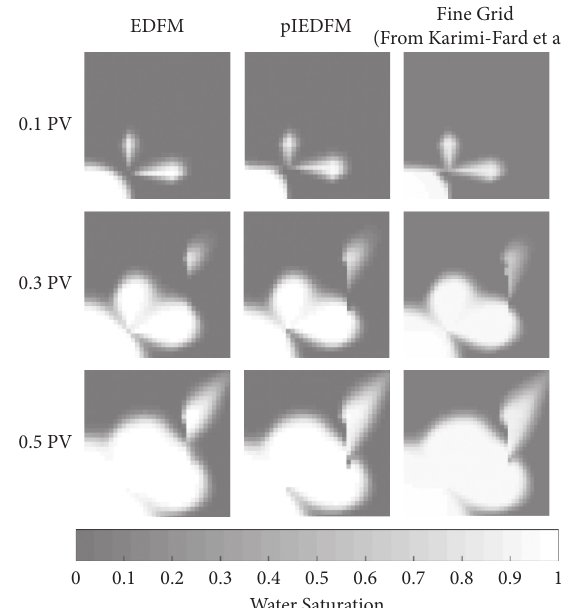
Figure 8: Water saturation profiles after 0.1 PV, 0.3 PV, and 0.5 PV of water